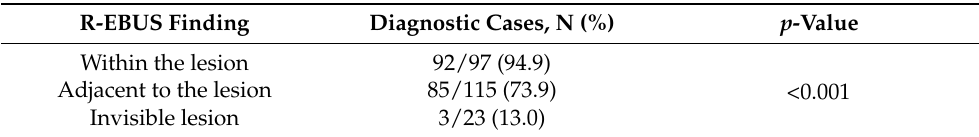
Table 4. Diagnostic yield according to R-EBUS